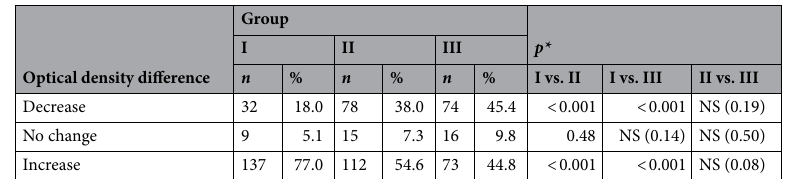
Table 5. Changes of optical density differences in particular groups—results after 2 year (baseline vs. follow-up 2). *p < 0.05